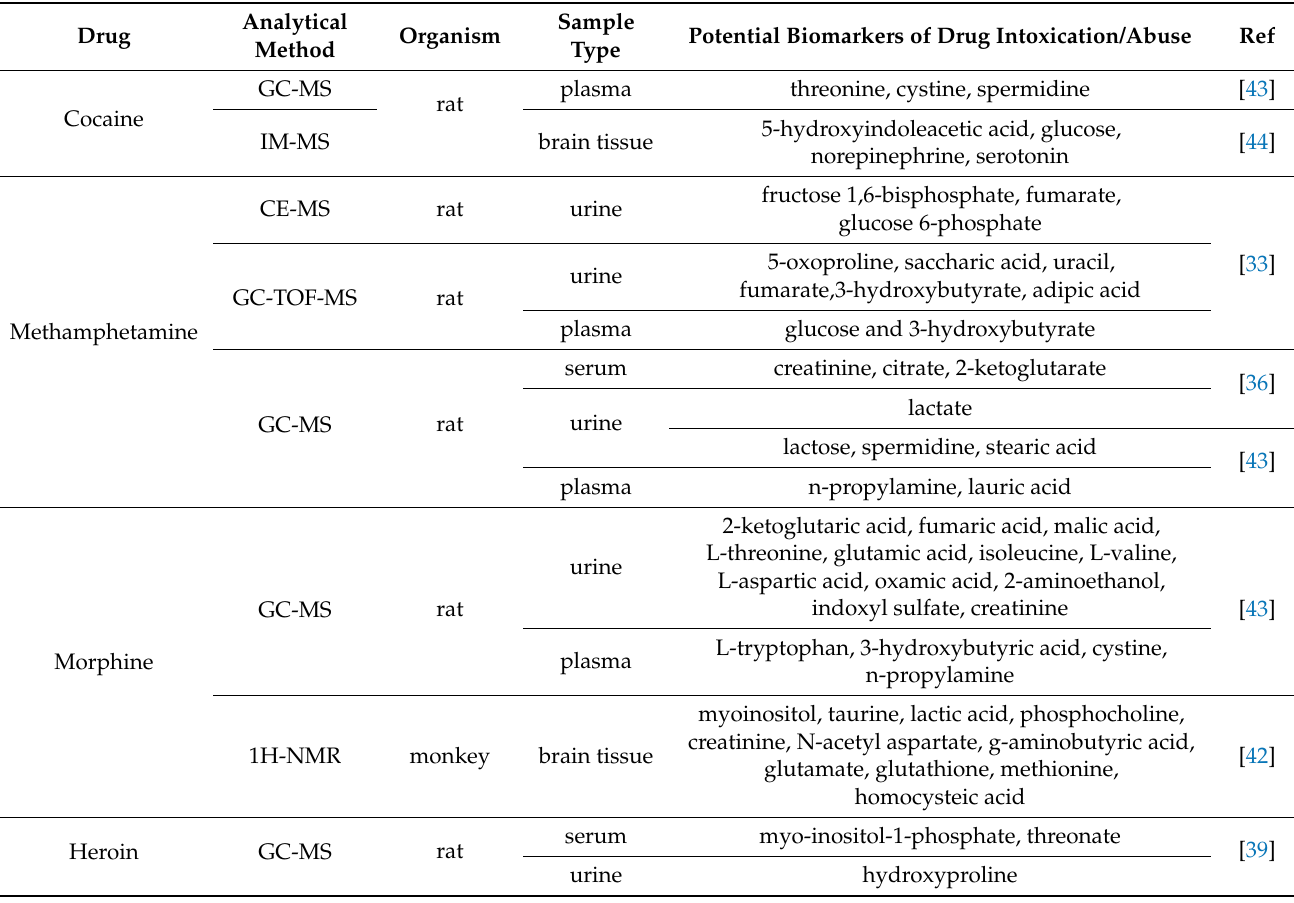
Table 2. Summary of studies using metabolomic analysis to detect metabolites as the potential biomarkers of drug intoxication/abuse in animal